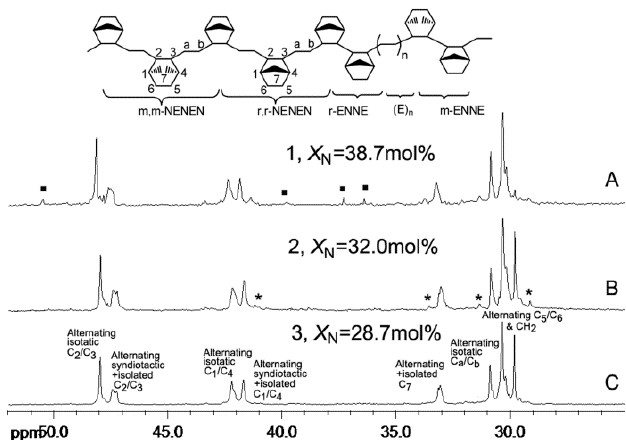
Figure 4. 13 C NMR spectra of the polyethylenes obtained from 1–3 /MAO at 2 g norbornene addition (entries 2, 6, and 8 in Table 2). (* represents signals of NN dyad, and ■ represents signals of NNN triad).